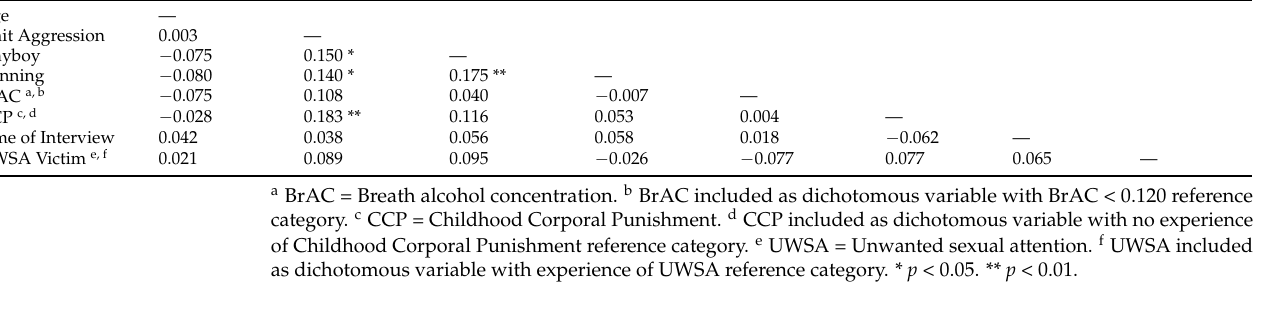
Table A2. Sample Demographic Information for Male